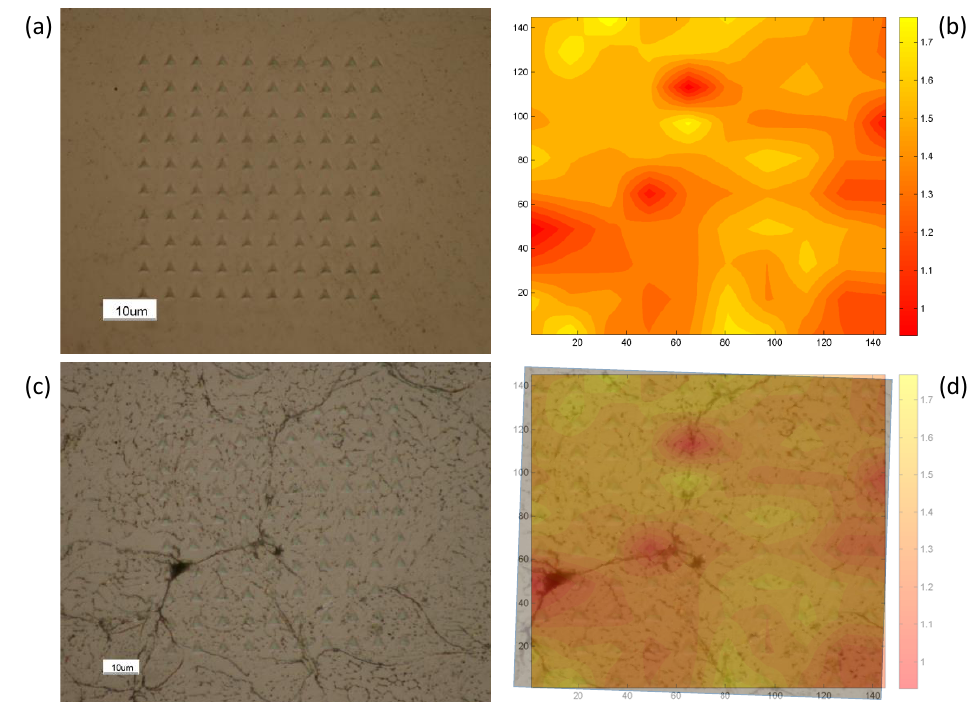
Figure 42. ( a ) Captures the optical micrograph of the Al 6061 cold spray consolidation in the orthogonal orientation relative to the deposition direction. ( b ) Captures the hardness contour plot using the indentation grid and location-specific 2D data from ( a ). ( c ) Depicts the same material region and indents presented in ( a ); however, the indented material was etched to reveal grain-related microstructural features in relation to their hardness’s depicted in ( b ). ( d ) Overlays the contour plot associated with ( b ) upon the etched micrograph in ( c ) for explicit microstructure-hardness comparison and inspection.